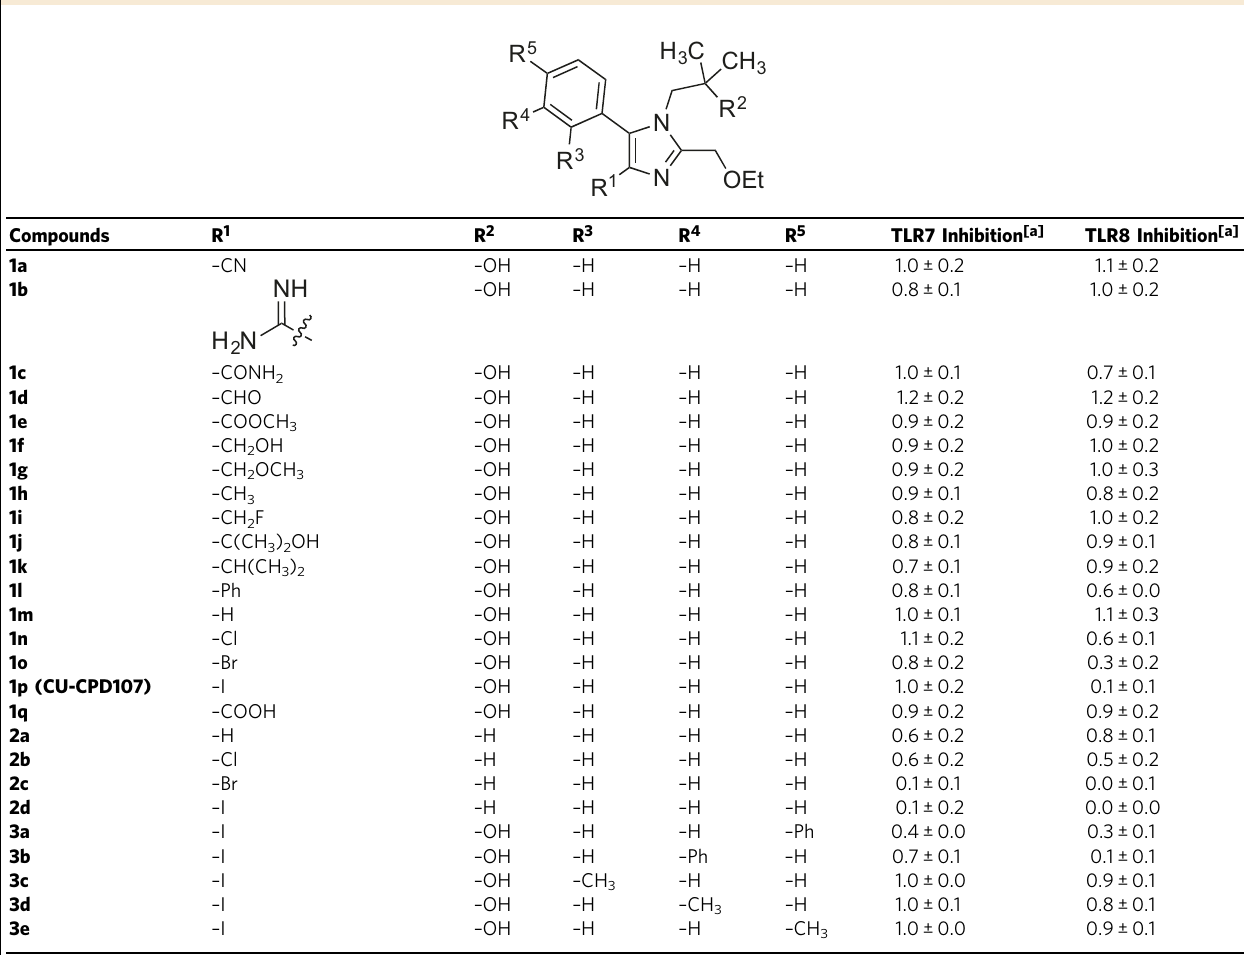
Table 1 Analysis of the structure – activity relationship of the tetrasubstituted imidazole